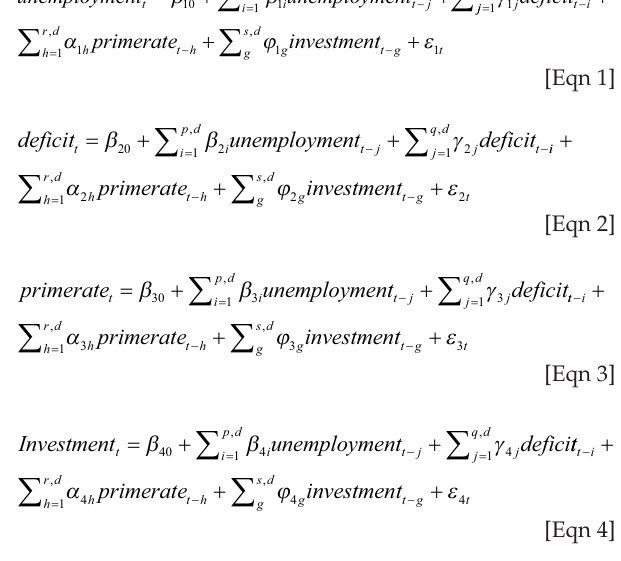
, φ , φ , φ , and φ are error correction 1 2 3 4 5 , α , ϑ , γ and ω are short-run i j j h g =φ =φ =φ =φ = 0 . If the observed F 1 2 3 4 5